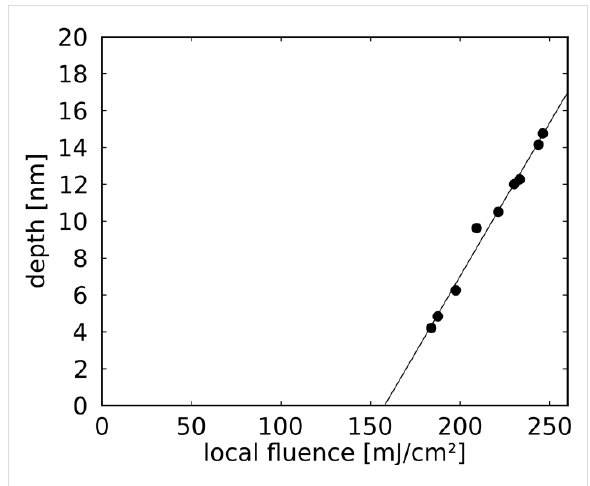
Figure 8: Hole depth (as determined from profiles such as in Figure 7b, measured with respect to the height of the flat surface) as a function of the incident local